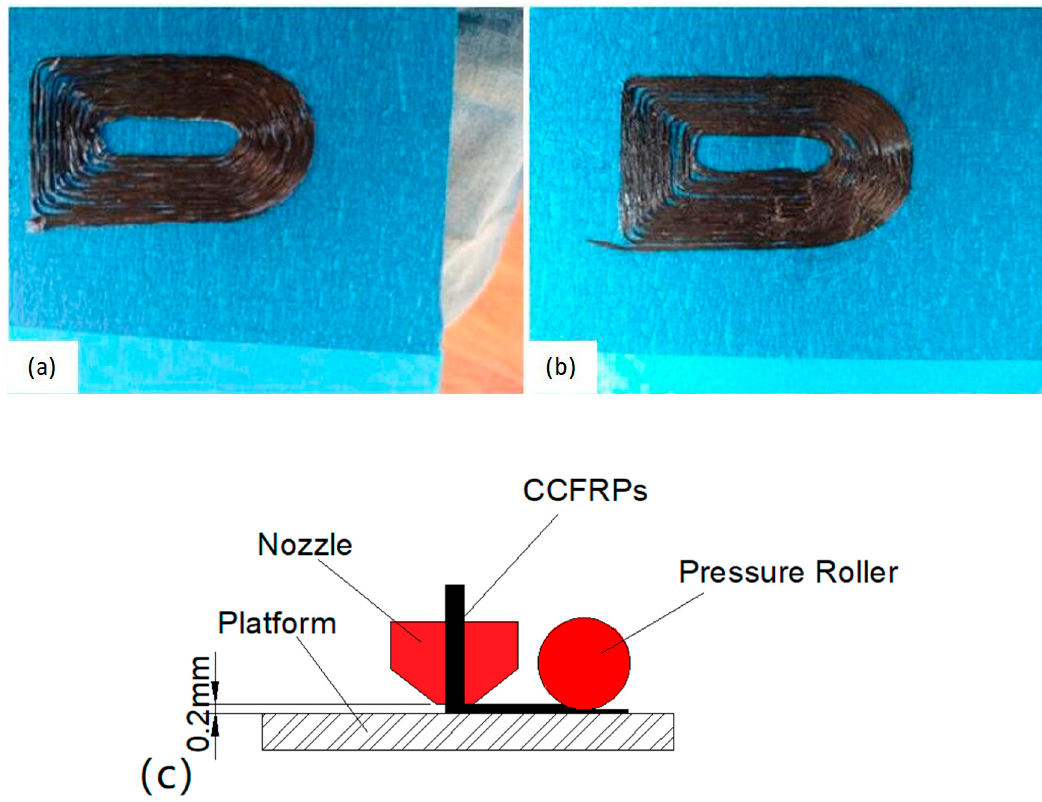
Figure 9. The printing model without pressure ( a ) and with pressure ( b ), and ( c ) the schematic diagram of the pressurized printing CCFRPs.